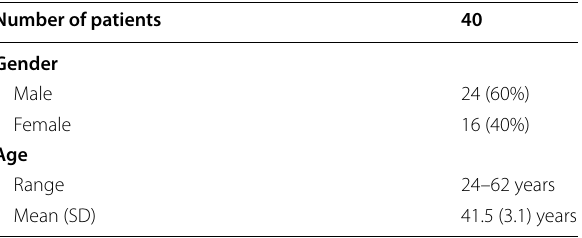
Table 1 Age and gender distribution